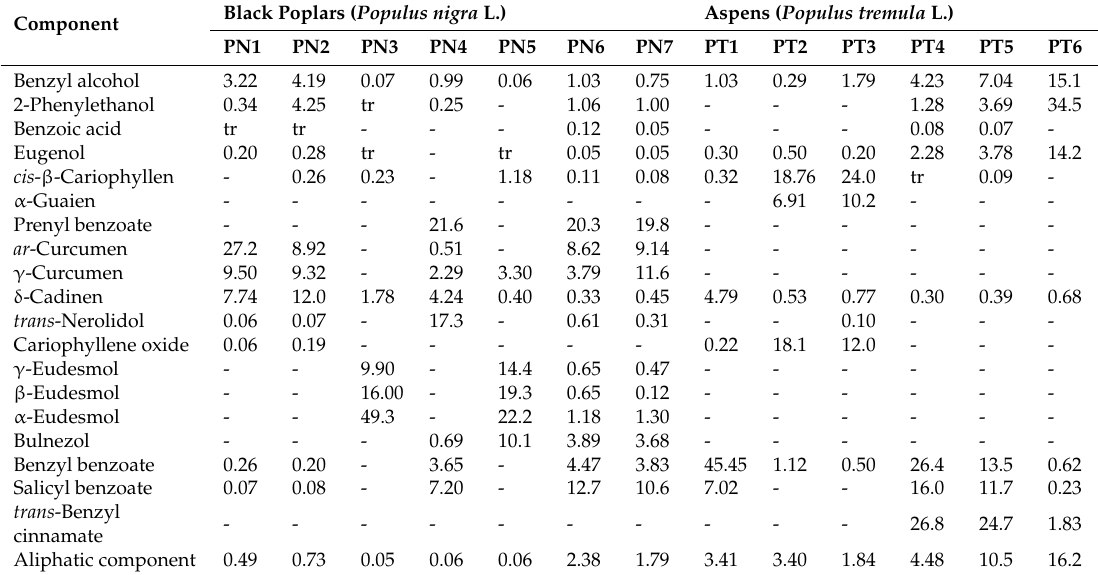
Table 1. Main components of Populus spp. buds essential oils